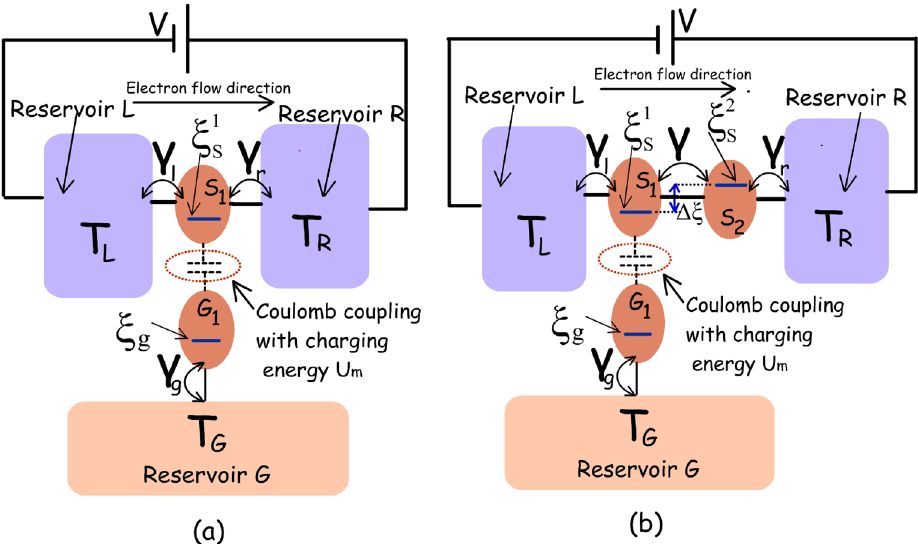
Figure 1. Schematic of the dual dot and triple dot thermometer ( a ) Schematic diagram of the dual dot thermometer based on Coulomb-coupled systems 10 . This thermometer set-up is based on a